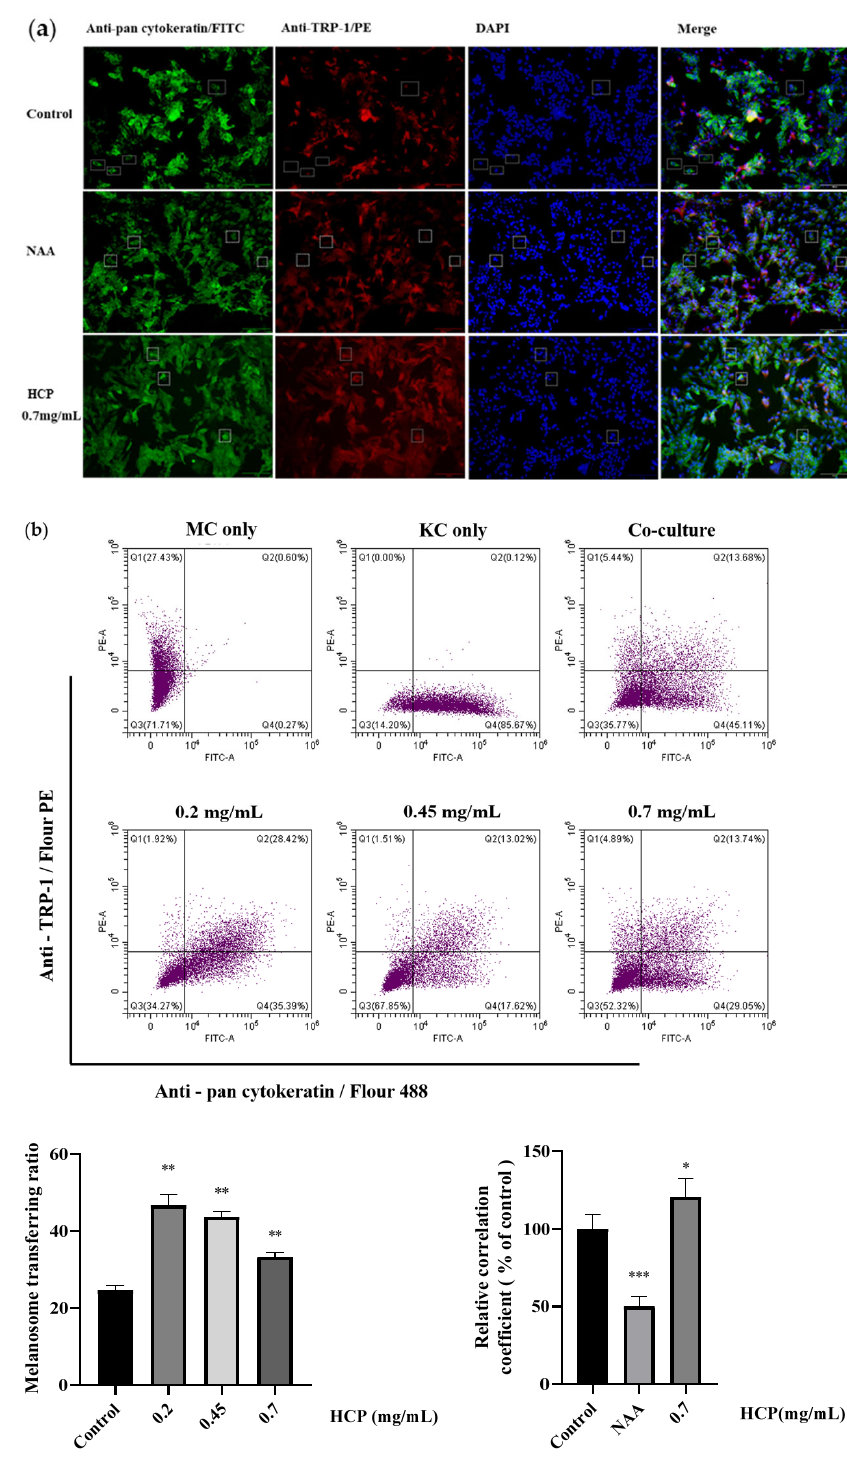
Figure 7. Effects on melanosome transfer in in the co-culture of melanoma and keratinocytes. Promotion of melanosome transfer in the co-culture of melanoma and keratinocytes in the presence and absence of HCP. ( a ) immunofluorescence staining; ( b ) flow cytometry. All data are expressed as mean ± SD ( n ≥ 3) (*** p < 0.001, ** p < 0.01 and * p < 0.05 vs. the untreated control.)